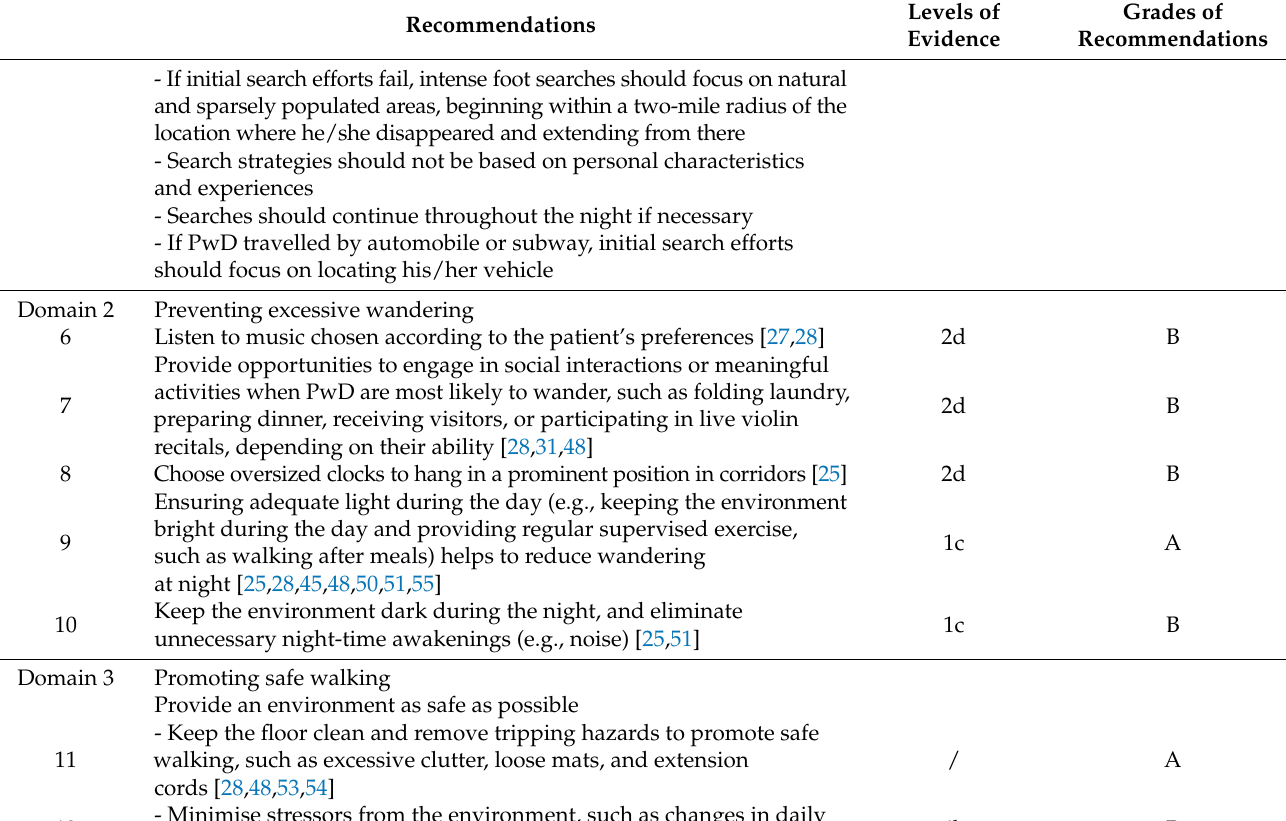
Levels of Evidence